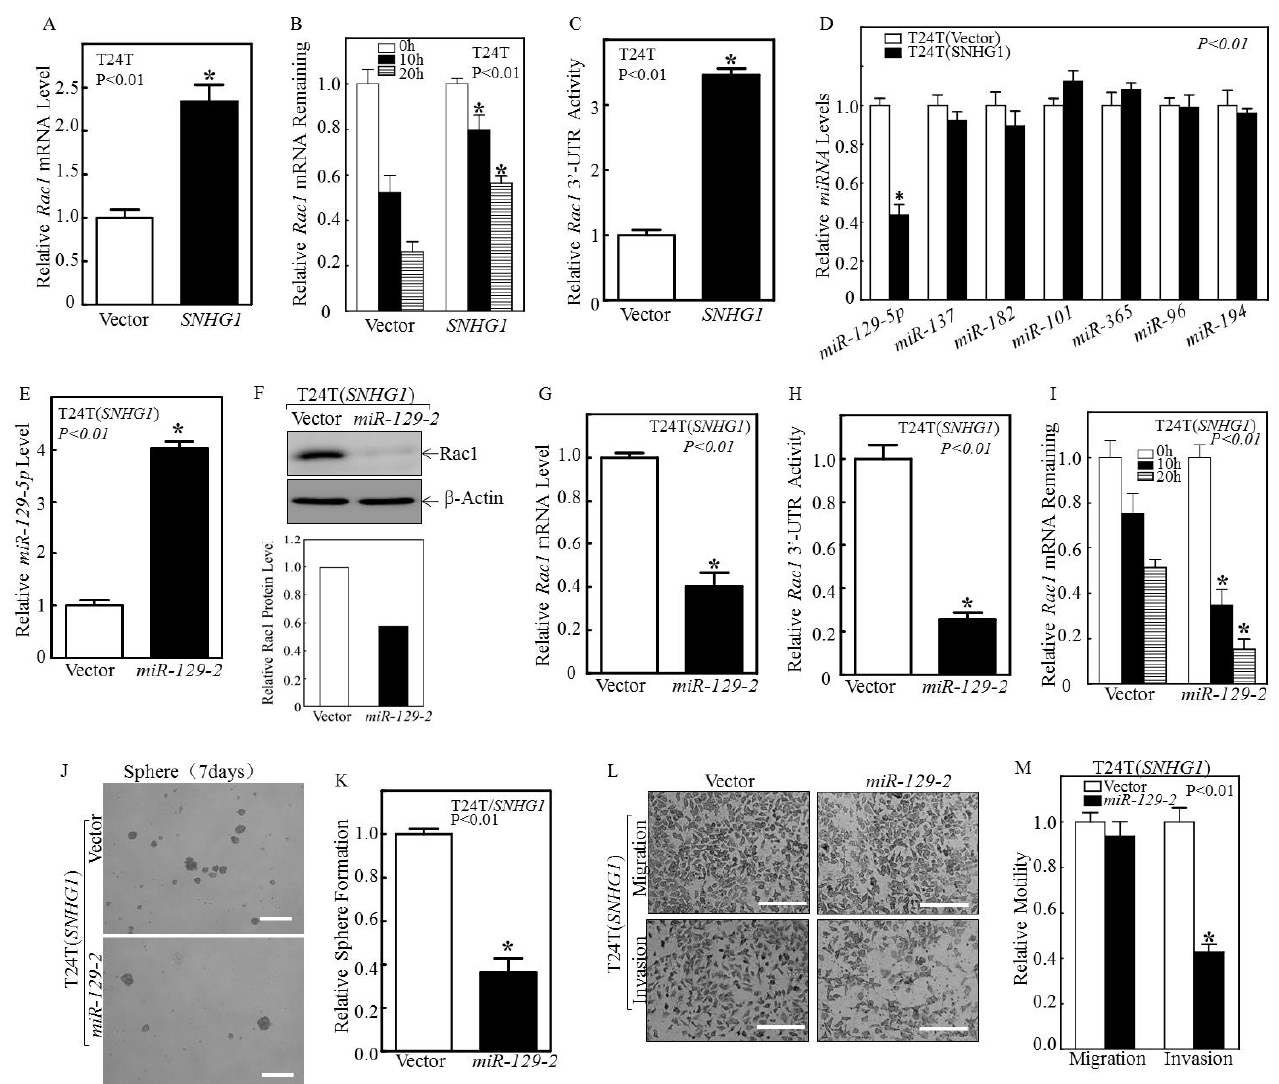
Figure 3. SNHG1 over-expression promoted the stability of Rac1 mRNA by inhibiting miR-129-2-5p induction in BC cells. ( A ) The Rac1 mRNA levels were quantified in T24T(Vector) and T24T(SNHG1) cells by real-time PCR with GAPDH as an internal control. ( B ) The T24T(Vector) and T24T(SNHG1) cells were seeded into 6-well plates; after synchronization, the cells were treated with Act-D for 0, 10, and 20h. Total RNA was then isolated and subjected to the real-time PCR quantification of Rac1 mRNA with GAPDH as an internal control. ( C ) The Rac1 mRNA 3 (cid:48) -UTR luciferase reporter was transiently transfected into the indicated cells, and the luciferase activity of each transfectant was assayed and normalized using pRL-TK as an internal control and presented relative to the vector transfectant. ( D ) Quantitative real-time PCR was carried out to determine the expression levels of key miRNAs in the indicated cells. ( E ) Stable transfection of miR-129-2 plasmids into T24T(SNHG1) cells, followed by the detection of miR-129-5p by real-time PCR. ( F , Top panel) Protein lysates extracted from the indicated cells were subjected to Western blotting to assess Rac1 expression. β -Actin served as a loading control. ( F , Bottom panel) Relative protein levels determined by densitometry and expressed as ratios versus β -Actin. ( G ) Quantitative real-time PCR was carried out to determine the expression of Rac1 mRNA in the indicated cells. ( H ) Wild-type Rac1 3 (cid:48) -UTR mRNA luciferase reporters were transiently co-transfected with pRL-TK into the indicated cells. The luciferase activity of each transfectant was evaluated, and the results are presented relative to Rac1 3 (cid:48) -UTR activity. ( I ) T24T(SNHG1) and T24T(SNHG1/miR-129-2) cells were incubated with Act-D for 0, 10, and